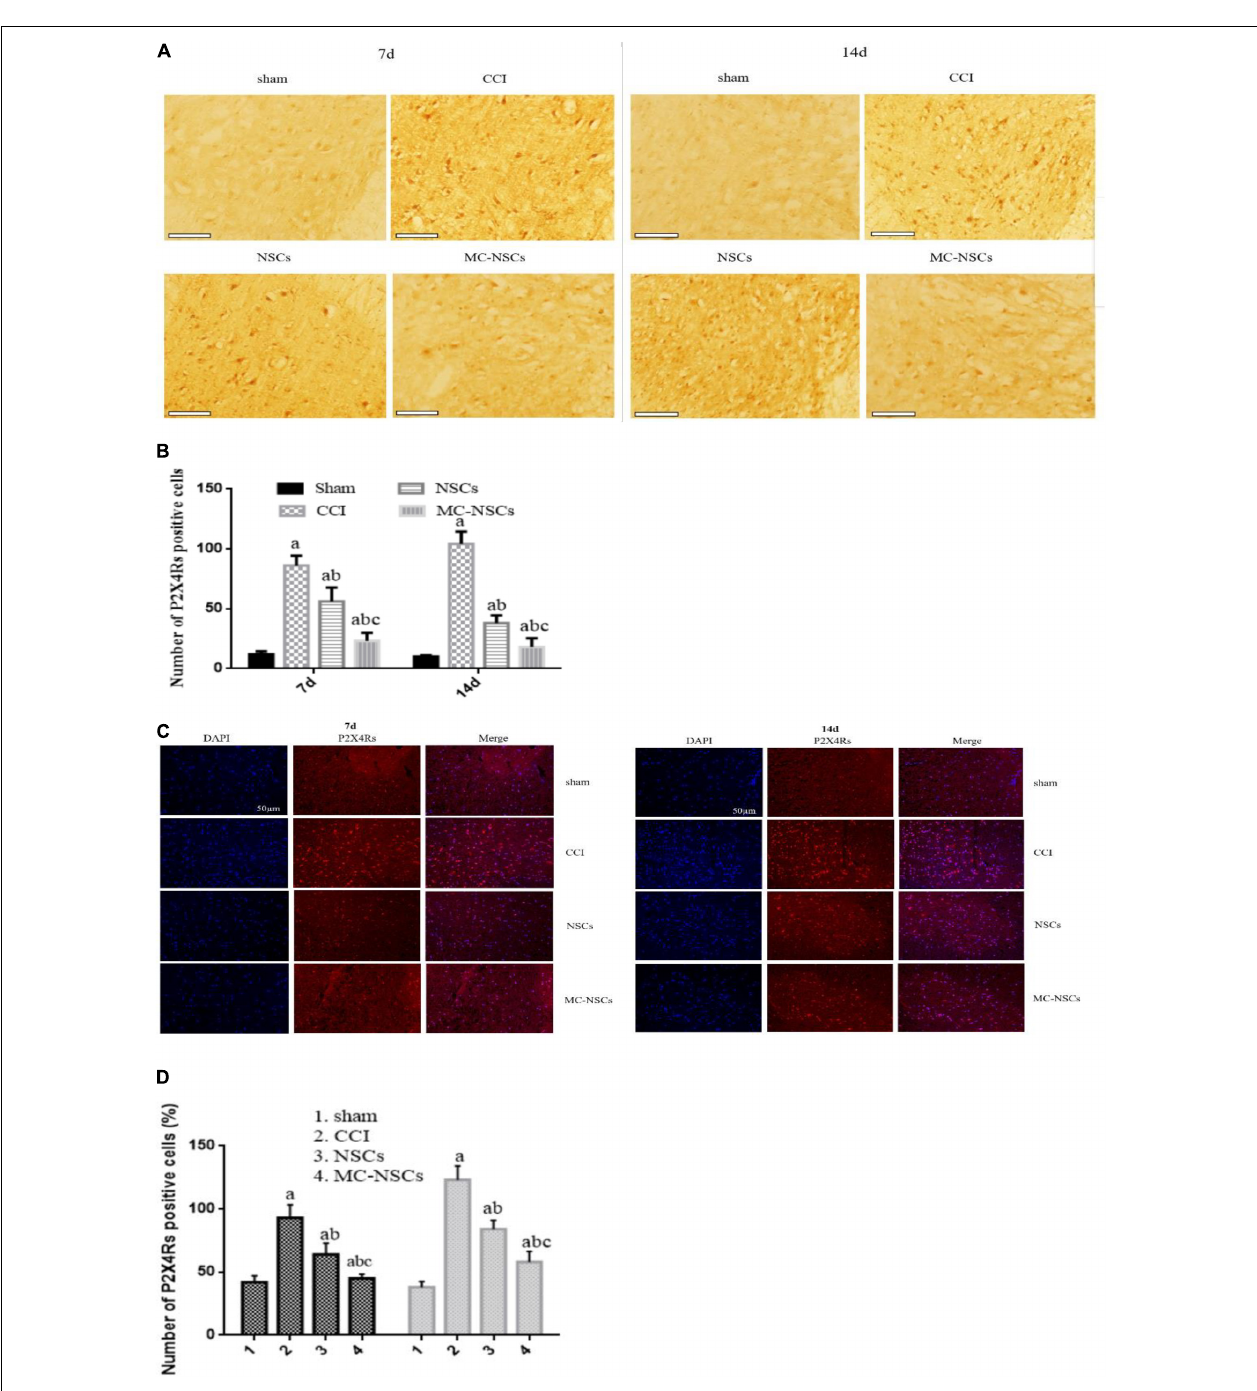
FIGURE 5 | Expression of P2 × 4R-positive cells in the L4–5 spinal cord segment. (A,B) In situ hybridization was performed to detect the staining of P2 × 4R-positive cells. Bar = 100 µ m. (C,D) Immunofluorescence was used to detect the expression of P2 × 4Rs in the spinal cord tissue of each group of rats. Data were expressed as the mean ± SD of three replicates ( n = 6). a p < 0.05 vs. sham group; b p < 0.05 vs. CCI group; c p < 0.05 vs. NSC